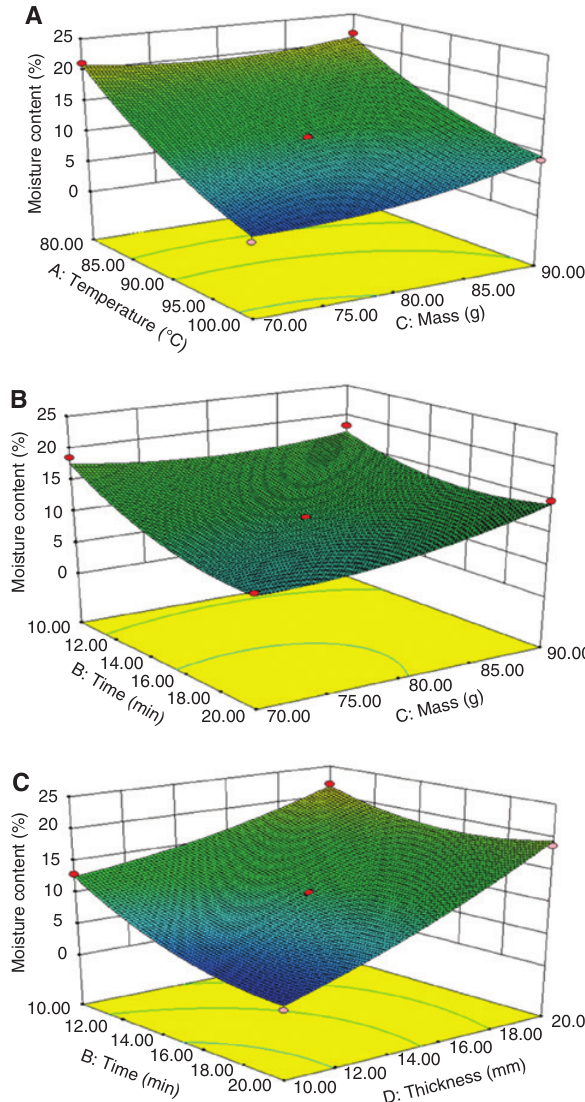
Figure 7: Three-dimensional response surface plot of moisture content: effects of the statistically significant interaction factors on moisture content of zinc oxide leach